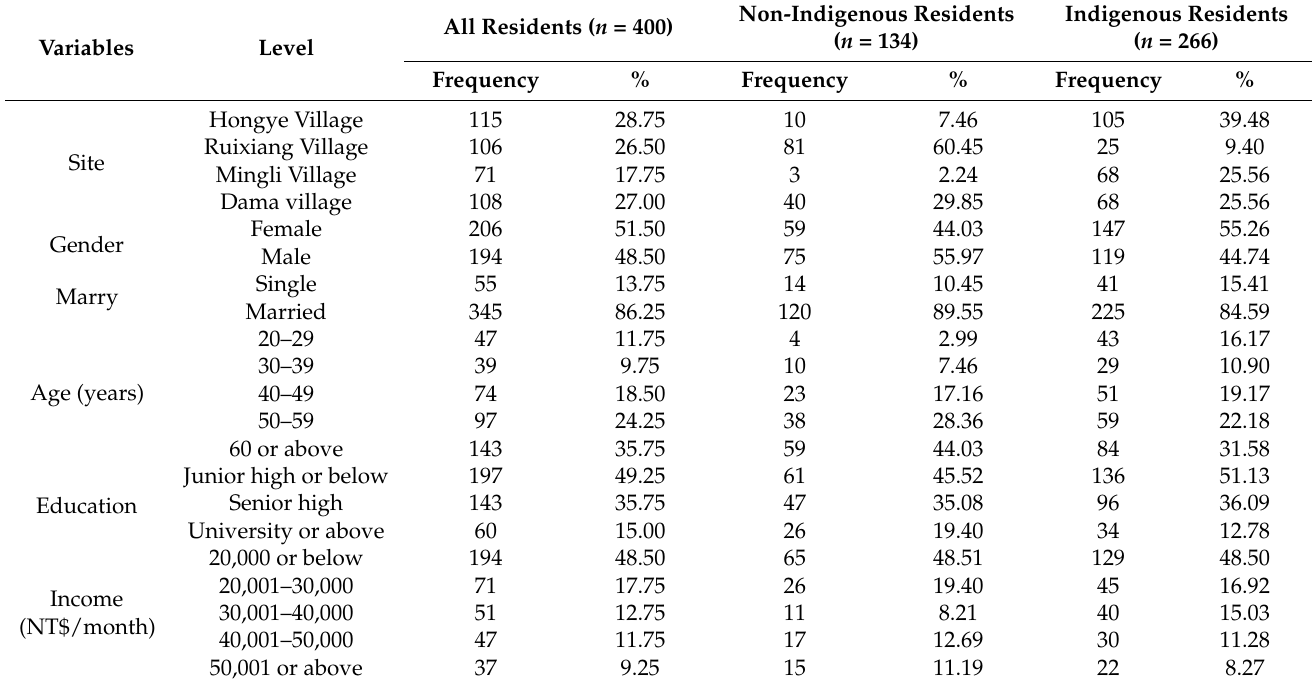
Table 2. Definition of Variables in the Residents’ Socio-economic Background